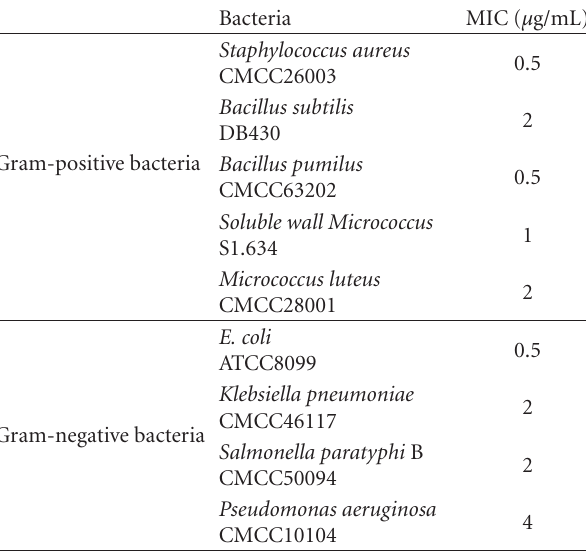
Table 4: MICs of peptide K11 for di ff erent bacteria.